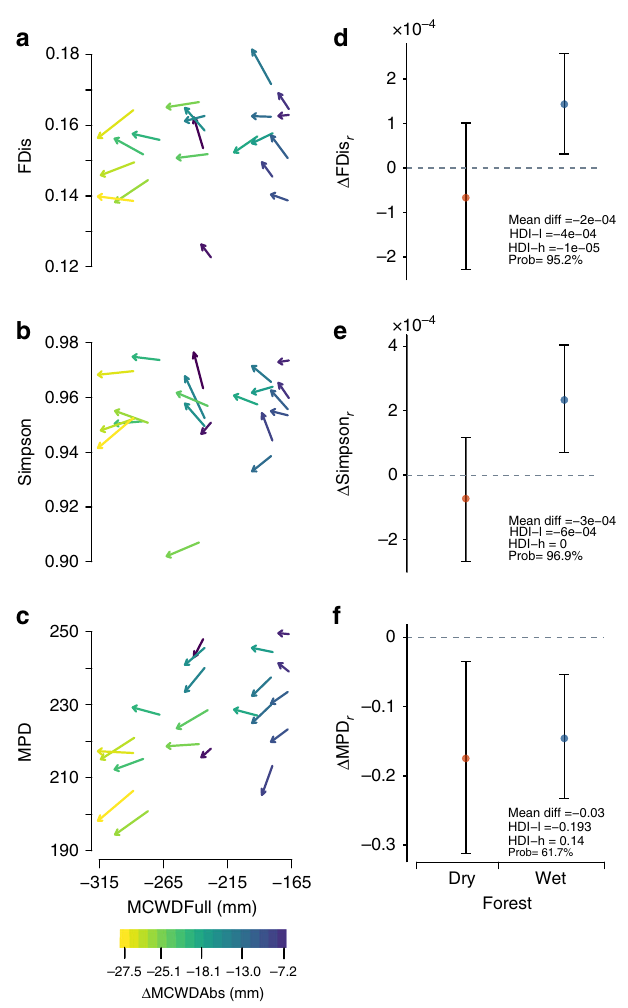
Fig. 2 Changes in the three facets of diversity, functional (FDis), taxonomic (Simpson) and phylogenetic (MPD) across time and climatic gradient. In a – c each arrow represents a vegetation plot ( n = 21), with the tail of the arrow showing the diversity level during the fi rst vegetation census and the head of the arrow the diversity level during the last vegetation census. The slope of the arrow represents the change in diversity across time, so that arrows pointing upwards show increases and downwards decreases in diversity. Arrow colours re fl ect the absolute change in maximum climatic water de fi cit ( Δ MCWD Abs ) experienced by the forest community (colour bar at the bottom of the fi gure). The X -axis shows the full-term maximum climatic water de fi cit (MCWD Full covering the 1964 – 2013 period) and the Y -axis the facets of diversity. d – f Show the average rate of change (coloured dots) and highest density intervals (vertical lines) in the three facets of diversity ( Δ FDis r , Δ Simpson r and Δ MPD r ) after grouping the vegetation plots as belonging to dry or wet forest ( n = 21). The horizontal dotted line represents no change in diversity with positive values showing increases and negatives values decreases in diversity. The insets on the bottom right corner show the average difference in diversity change between dry and wet forests. Negative average difference values depict a stronger loss in the diversity facet in drier forests in comparison to wetter forests. The posterior highest density intervals (HDI-l: lower; HDI-u: upper) and probability change (Prob) values are also diversity decreased the most (up to − 3.9 e − 4 yearly rate and − 7.2 e − 3 in total for plot BBR_16) in areas that experienced the strongest negative Δ MCWD Abs ( − 27.5 mm; Fig. 3a) and increased (yearly rate of up to 4.3 e − 4 for CAP_10 and 4.2 e − 4 for